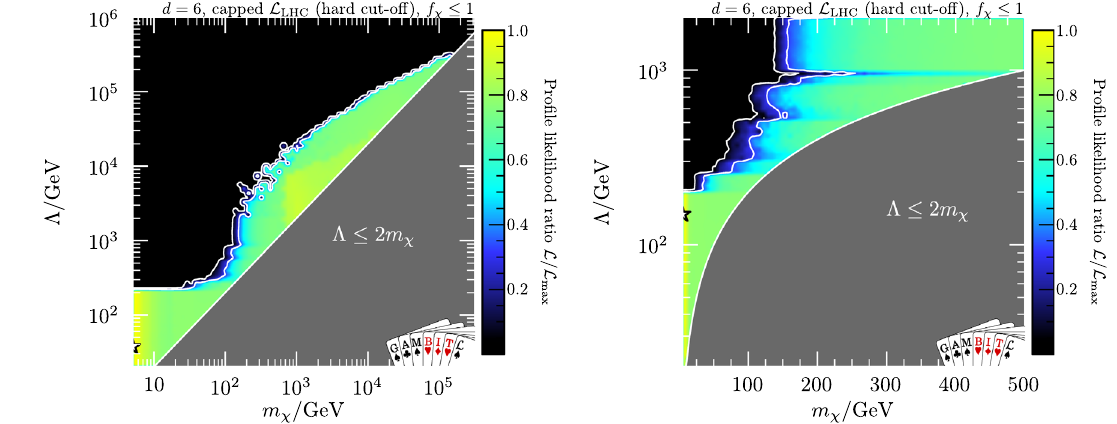
Fig. 2 Profile likelihood in the m χ – (cid:2) plane when considering only dimension-6 operators and capping the LHC likelihood at the value of the background-only hypothesis. The white contours indicate the 1 σ and2 σ confidenceregionsandthebest-fitpointisindicatedbythewhite star. The shaded region (corresponding to (cid:2) ≤ 2 m χ ) is excluded by the